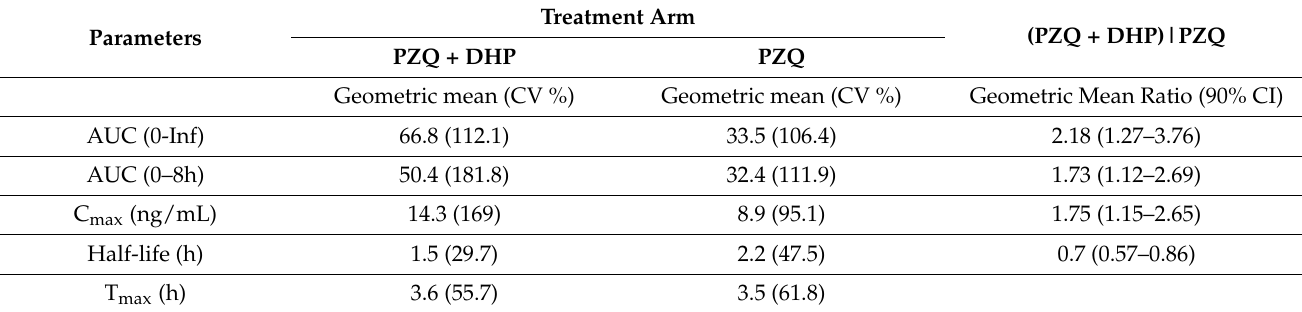
Table 2. Comparisons of pharmacokinetic parameters of total PZQ between PZQ + DHP and PZQ treatment